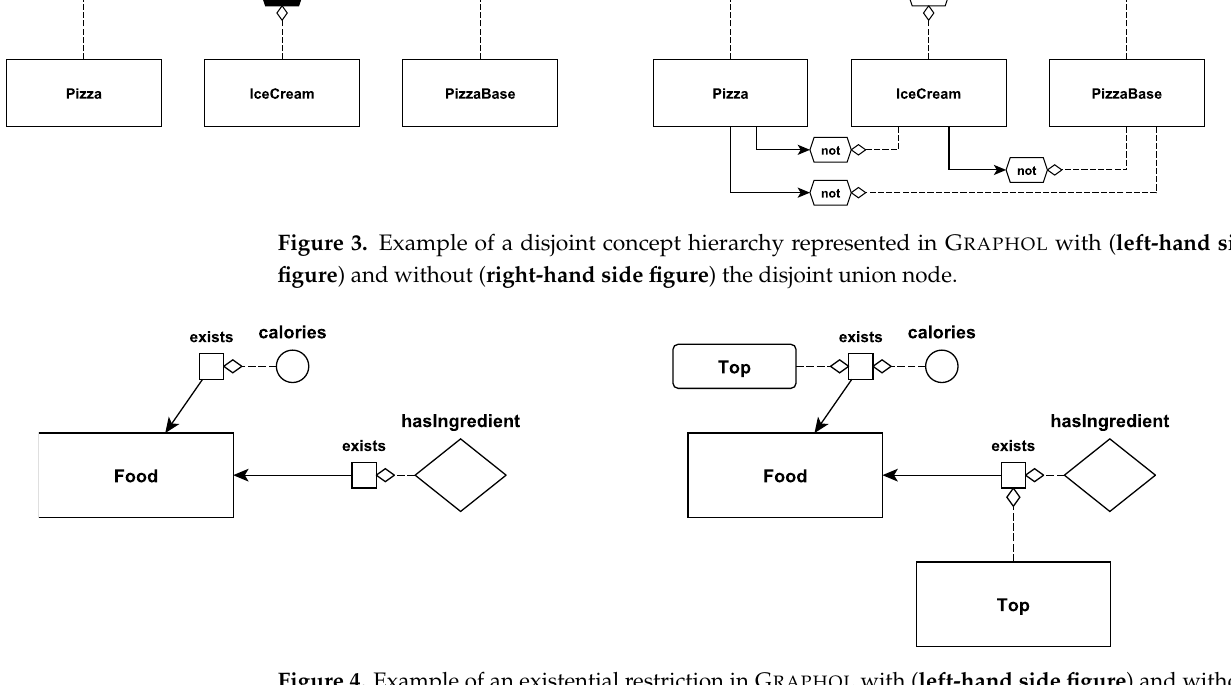
Figure 4. Example of an existential restriction in G RAPHOL with ( left-hand side figure ) and without ( right-hand side figure ) the compact